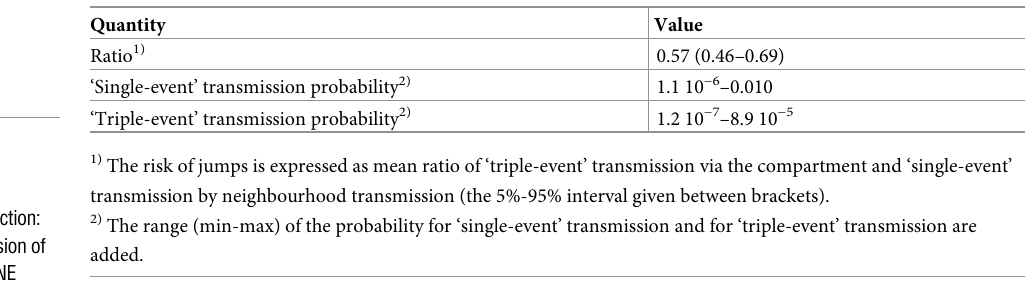
Table 3. The risk of HPAI transmission jumps from one area to another, due to a compartment with one farm located in the